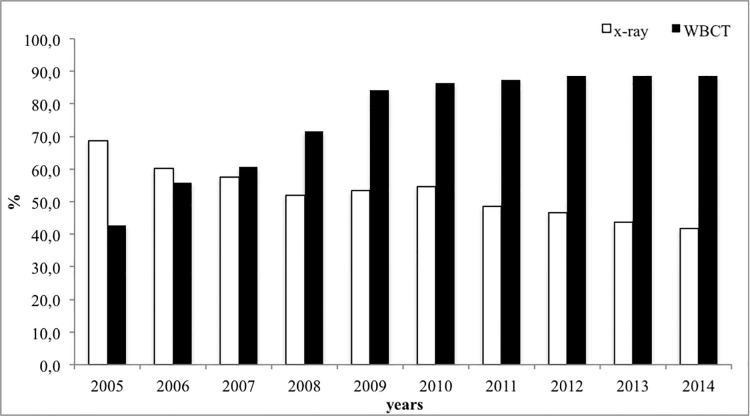
Use of plain x-rays and whole body CT (WBCT) between 2005 and 2014.